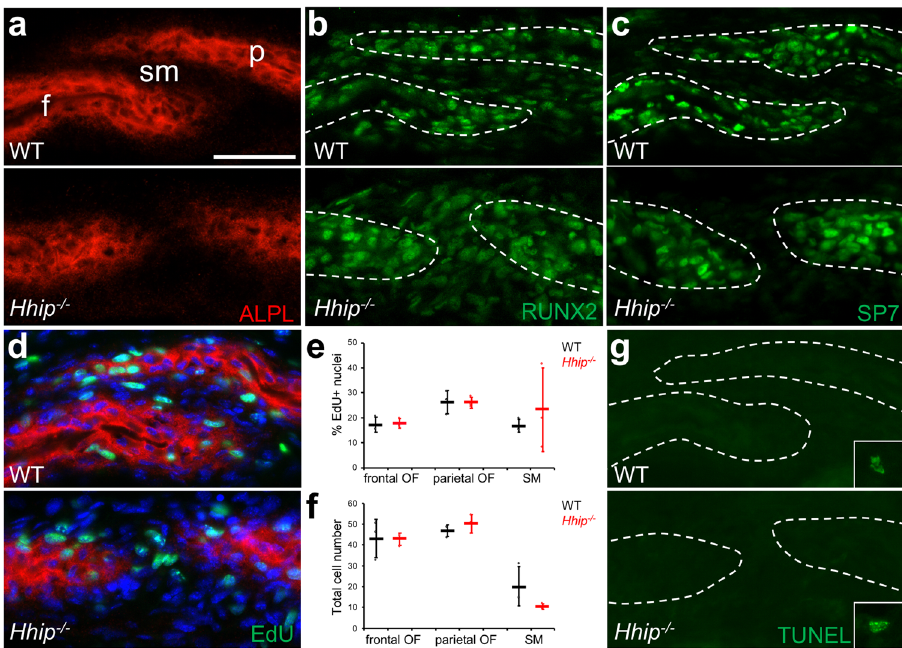
Fig. 5 Coronal suture dysgenesis in Hhip − / − mice at E16.5. a Staining for alkaline phosphatase activity (ALPL, red) in preosteoblasts and osteoblasts for wild type (WT) and mutant ( Hhip − / − ) coronal sutures. f frontal bone; p parietal bone, sm suture mesenchyme. b Immunohistochemistry for RUNX2 (green). Sections are the same as shown in a . c Immunohistochemistry for SP7 (green). d Proliferation detected by EdU incorporation (green). Sections are counterstained for ALPL activity (red) and DAPI (blue). e Quanti fi cation of EdU incorporation in osteogenic fronts (OF) and suture mesenchyme (SM). WT and Hhip − / − are indicated in black and red, respectively. n = 3 WT and three Hhip − / − . f Quanti fi cation of cell numbers per section in OFs and SM. n = 3 WT and three Hhip − / − . g TUNEL assay for apoptotic cells. Inset, example of an apoptotic cell in non-sutural tissue on the same slide. White dashed outlines, frontal and parietal bones. Data in e and f are presented as dot plots showing mean ± standard deviation. Results presented in a , b , c , d , and g are representative of n = 3 WT and three Hhip − / − independent samples. Sections are in the transverse plane. Scale bar, 50 μ m. Source data are provided as a Source Data fi